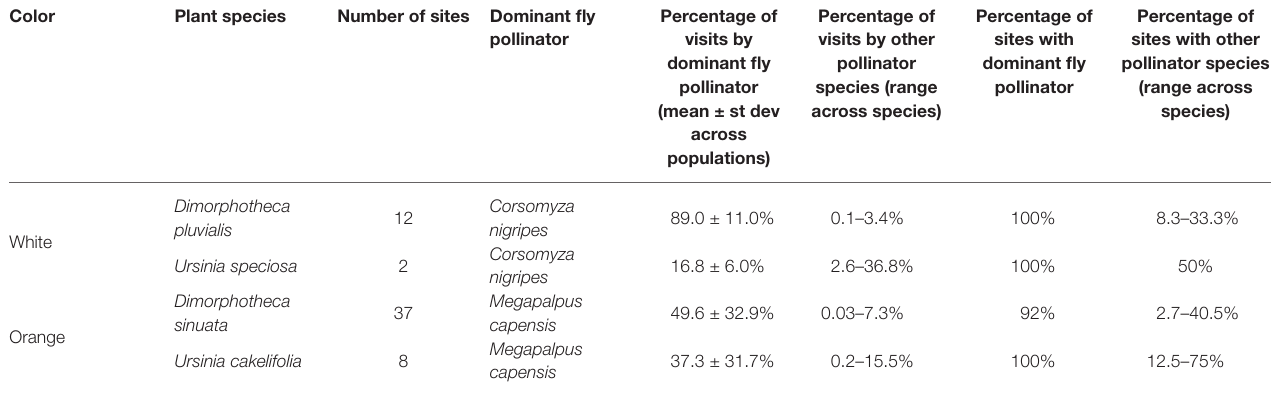
TABLE 2 | Consistency and frequency of dominant fly pollinators of the focal annual daisy species.